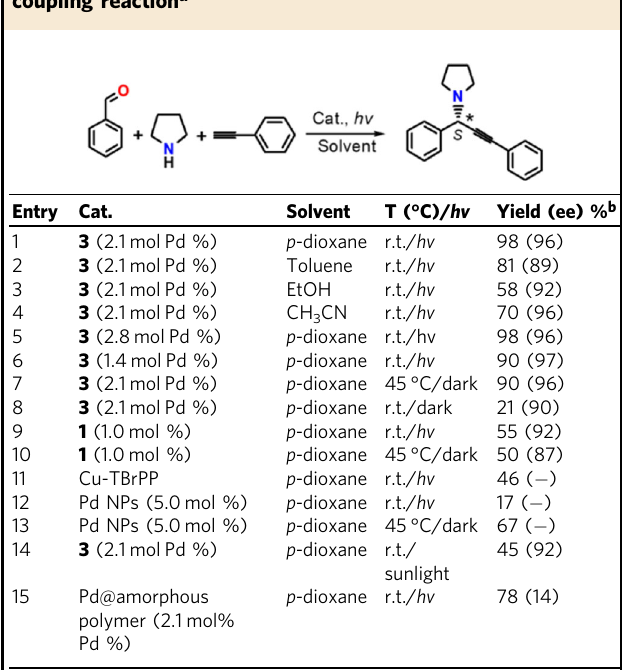
Table 3 Optimization of the 3-catalyzed asymmetric A 3 - coupling reaction a